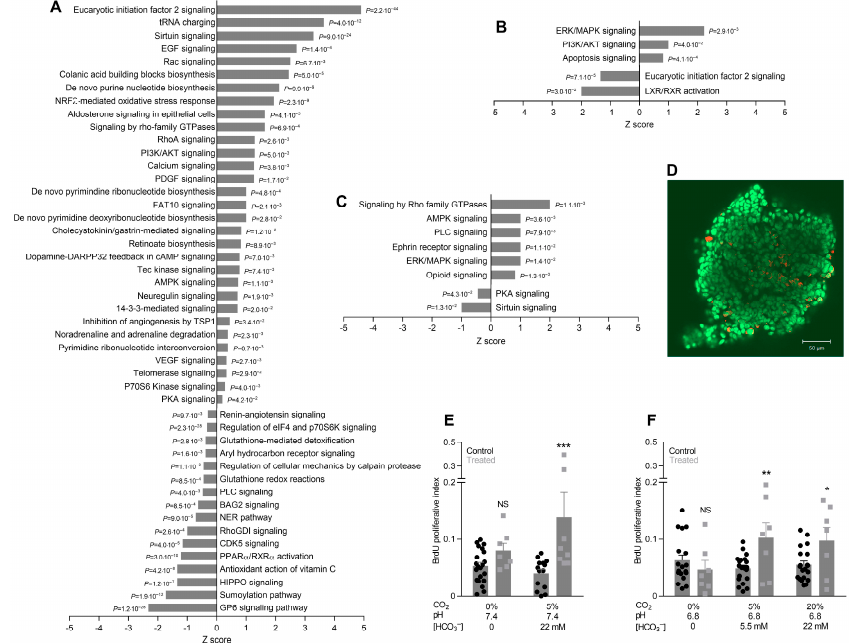
Figure 6. Breast cancer organoids from mice undergoing oral NaHCO 3 therapy show increased proliferative activity in vitro at both pH o 6.8 and 7.4 but only when investigated in the presence of CO 2 /HCO 3– buffer. ( A–C ). Protein expression changes for cellular signaling cascades. p -values were calculated based on Fisher’s right-tailed exact test. We compare breast cancer tissue vs. normal breast tissue from control mice ( A ), breast cancer tissue from NaHCO 3 -treated mice vs . control mice ( B ), and normal breast tissue from NaHCO 3 -treated mice vs. control mice ( C ). ( D ). Original image of breast cancer organoid fluorescently labeled using an anti-bromodeoxyuridine (BrdU) antibody (red). Nuclei are stained with SYTO16 (green). ( E, F ). BrdU proliferative index in breast cancer organoids from NaHCO 3 -treated mice and control mice ( n = 7–21) investigated at pH o 7.4 ( E ) and 6.8 ( F ). The BrdU proliferation index is the fraction of cells positive for BrdU after 6 h incubation and represents the rate of cell division during this period. Data were compared by two-way ANOVA followed by Bonferroni post-tests. * p < 0.05, ** p < 0.01, *** p < 0.001, NS: not significantly di ff erent vs. Control under similar